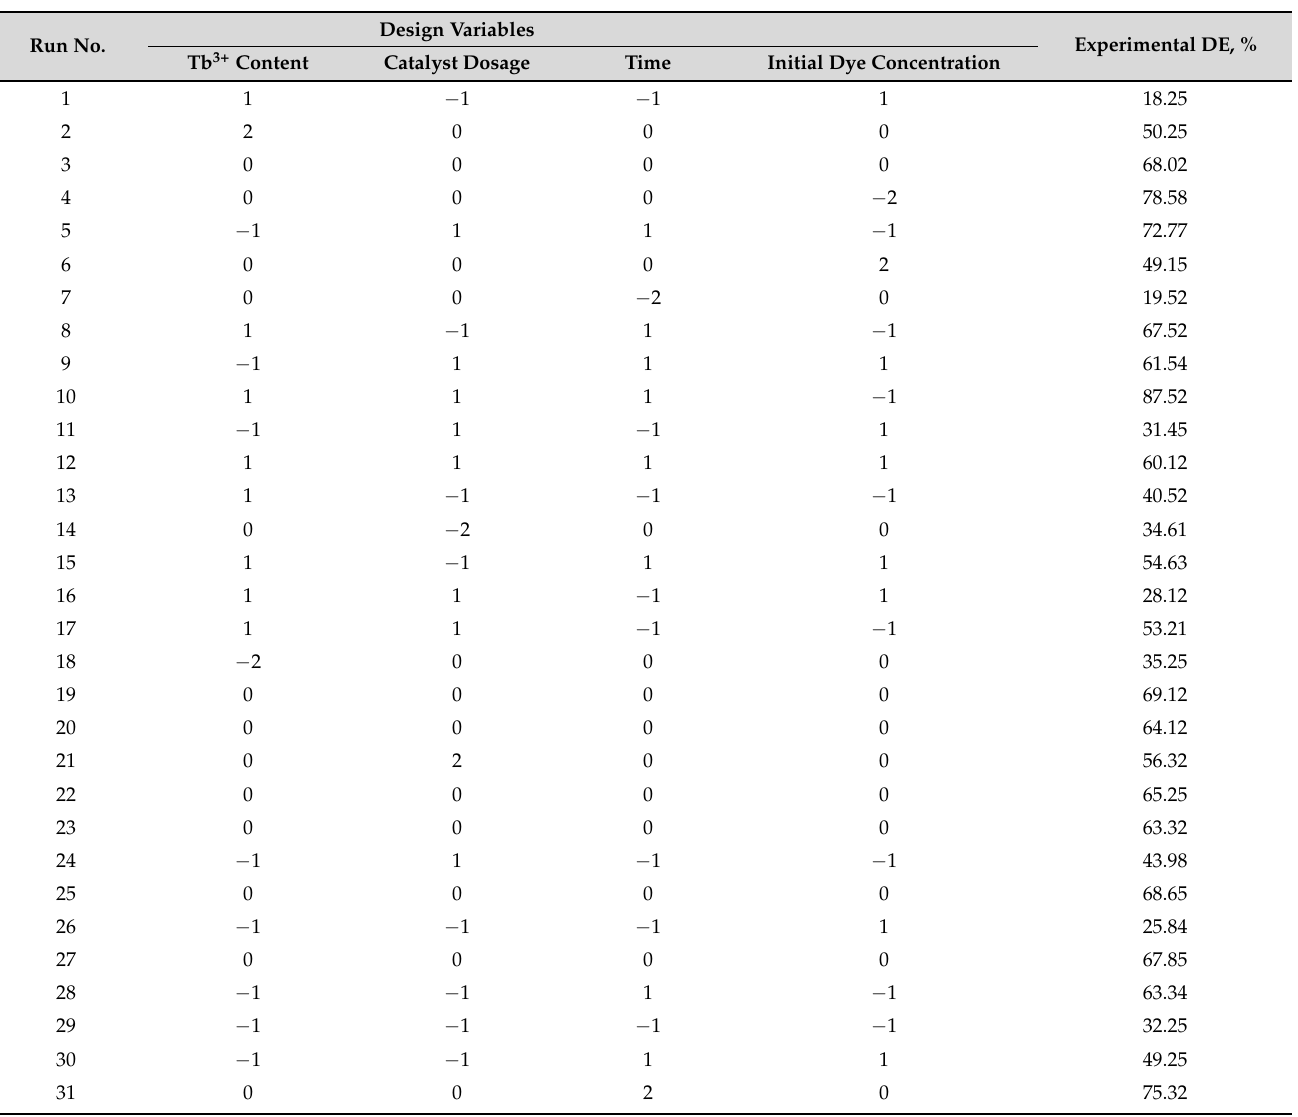
Table 3. Experimental design matrix and related decolorization efficiencies. Design Variables Run